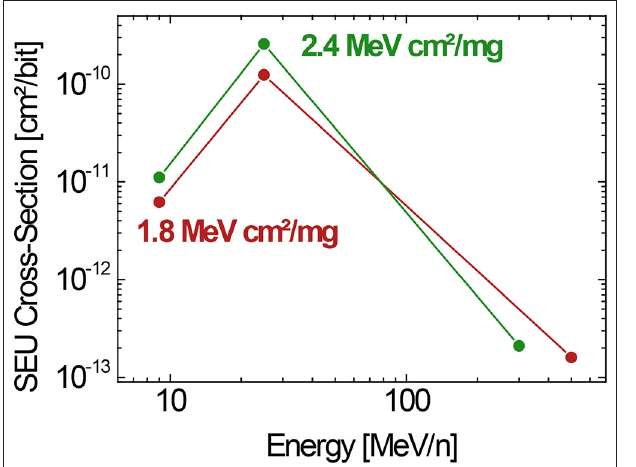
FIGURE 4 | Comparison of energy dependence at specific LET from [14].